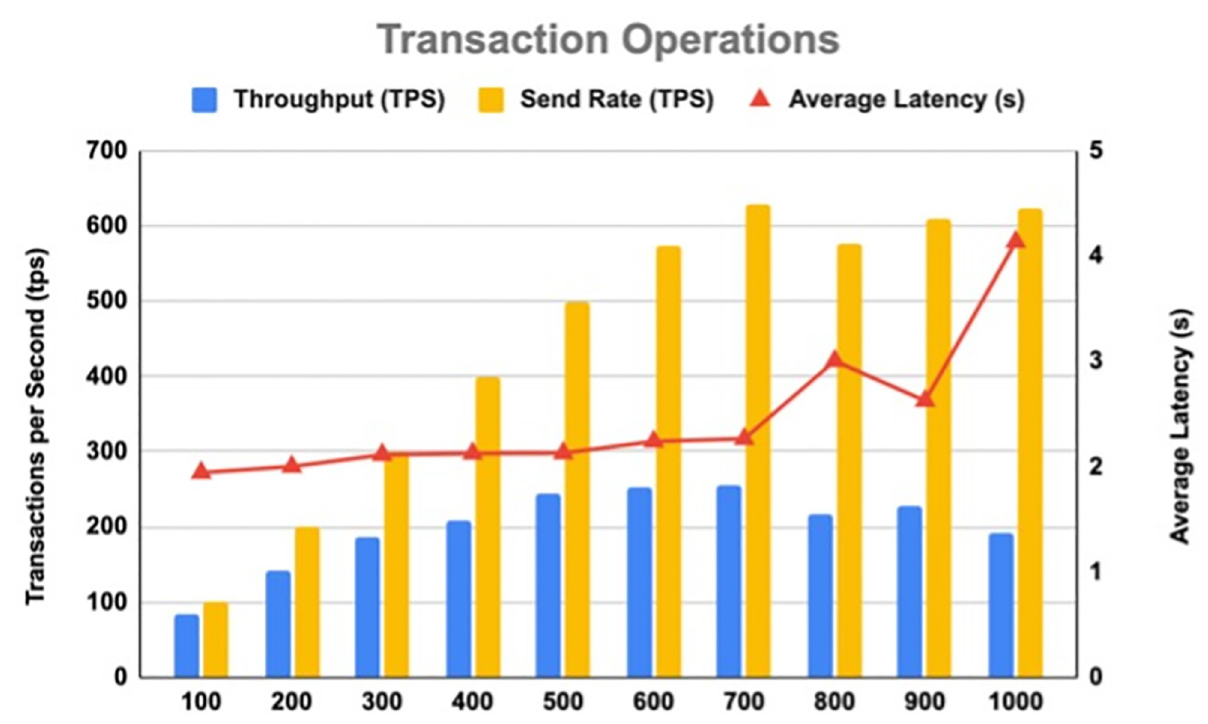
Fig 9. Throughput and latency for transaction